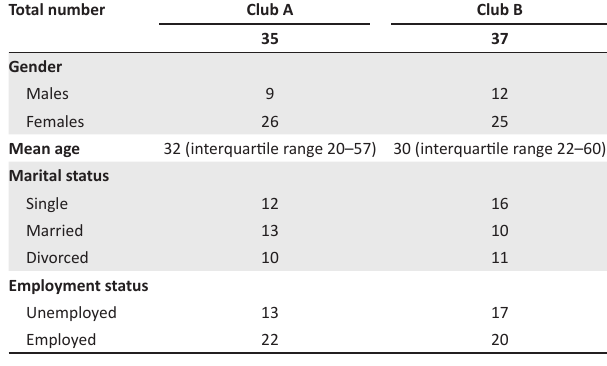
TABLE 3: Characteristics of patients in clubs A and